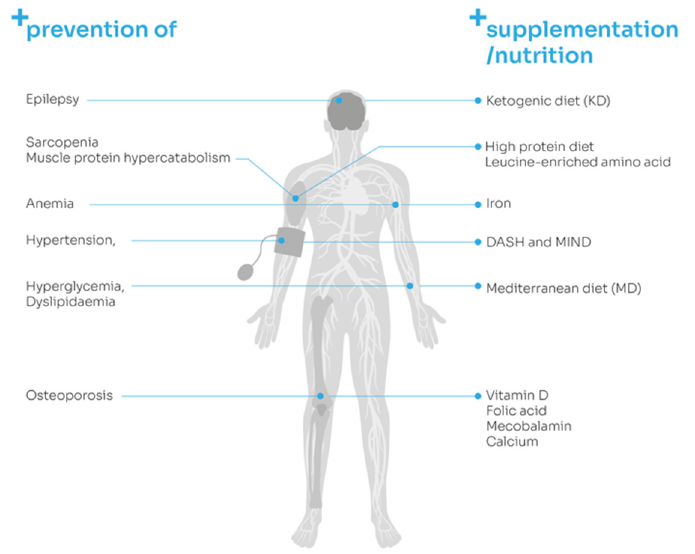
Figure 2. Potential preventive nutritional strategies in post-stroke patients.